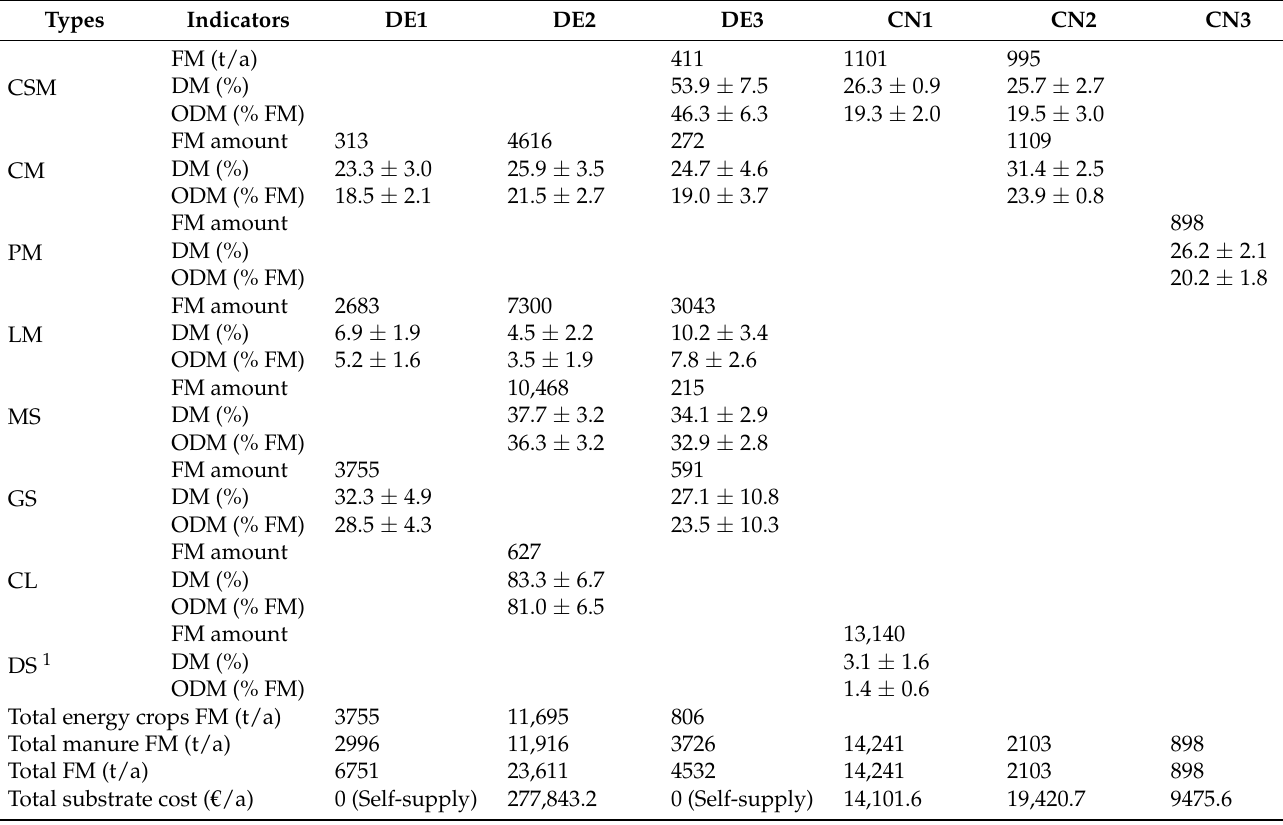
Table 2. Annual substrate input and characteristics in German (DE) and Chinese (CN) biogas plants. Results are averages ±